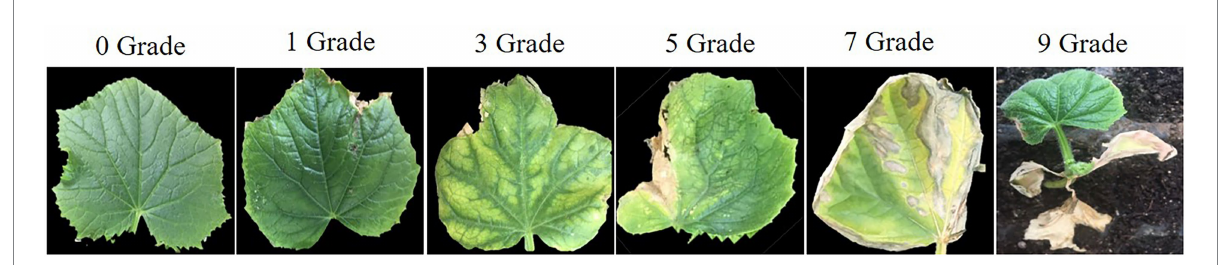
FIGURE 1 The disease rating scale of leaves at the seedling stage after infection with Didymella bryoniae